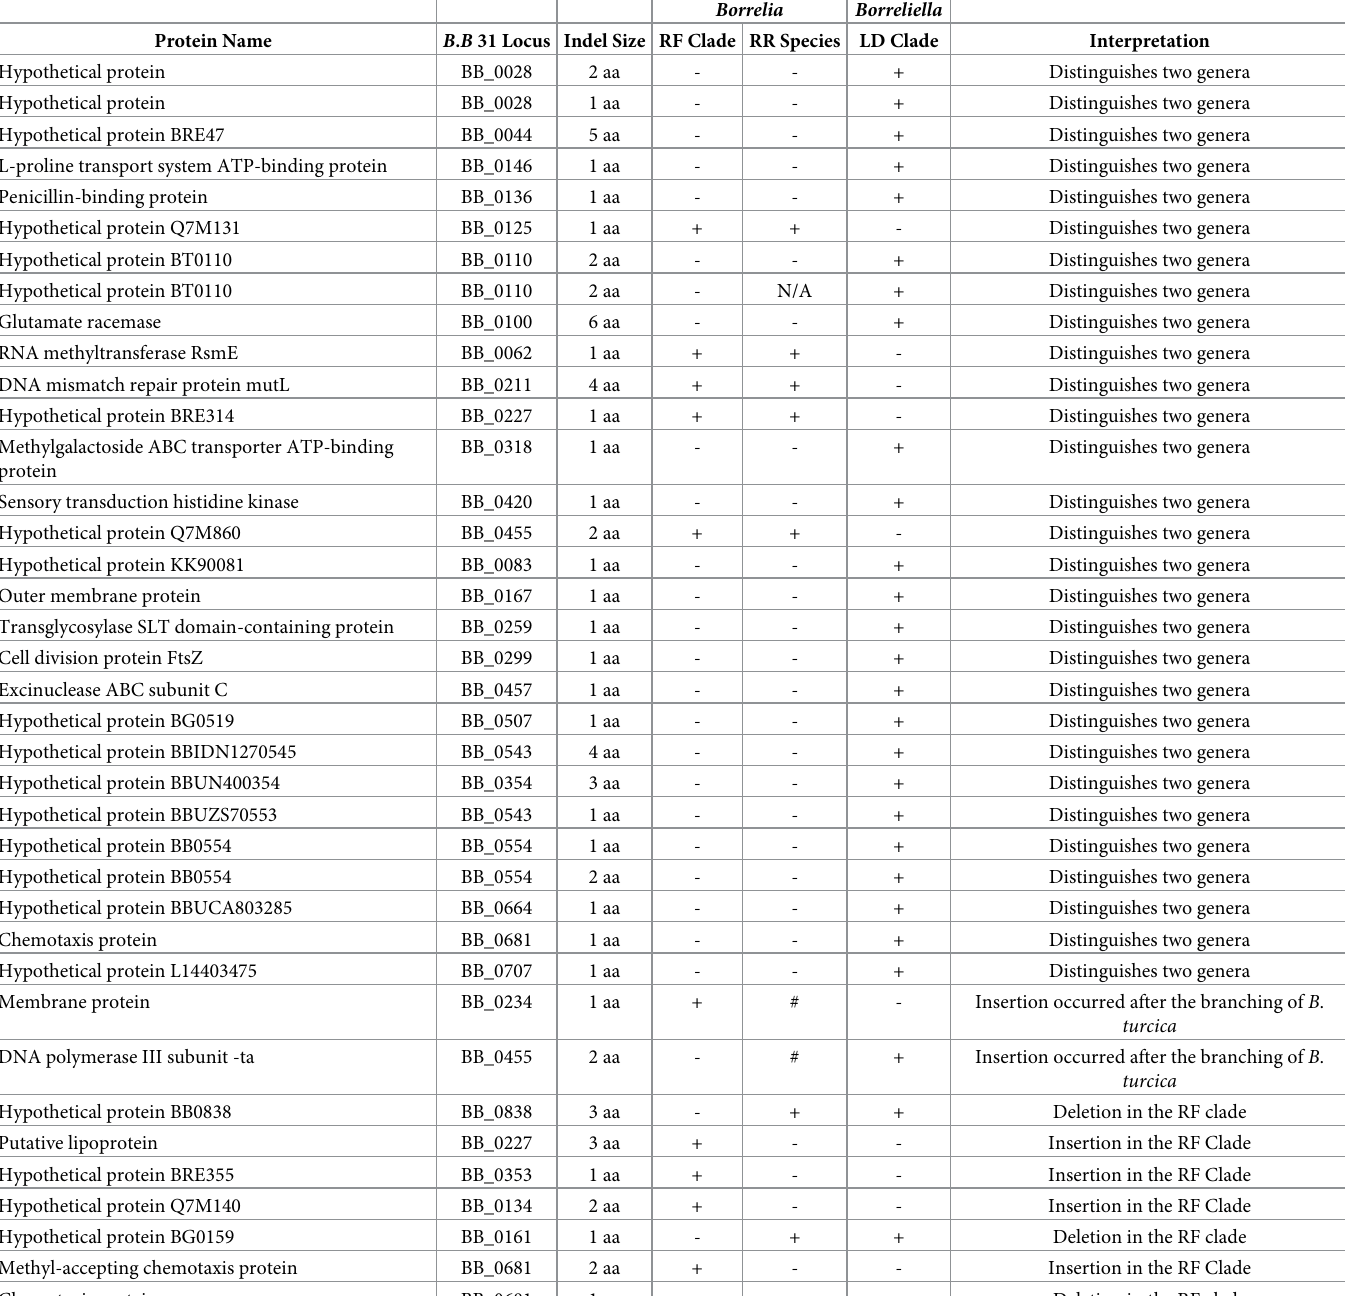
Table 3. Conserved signature indels in Borreliaceae -specific proteins distinguishing Borrelia and Borreliella and showing deeper branching of the RR group of spe- cies within the genus Borrelia